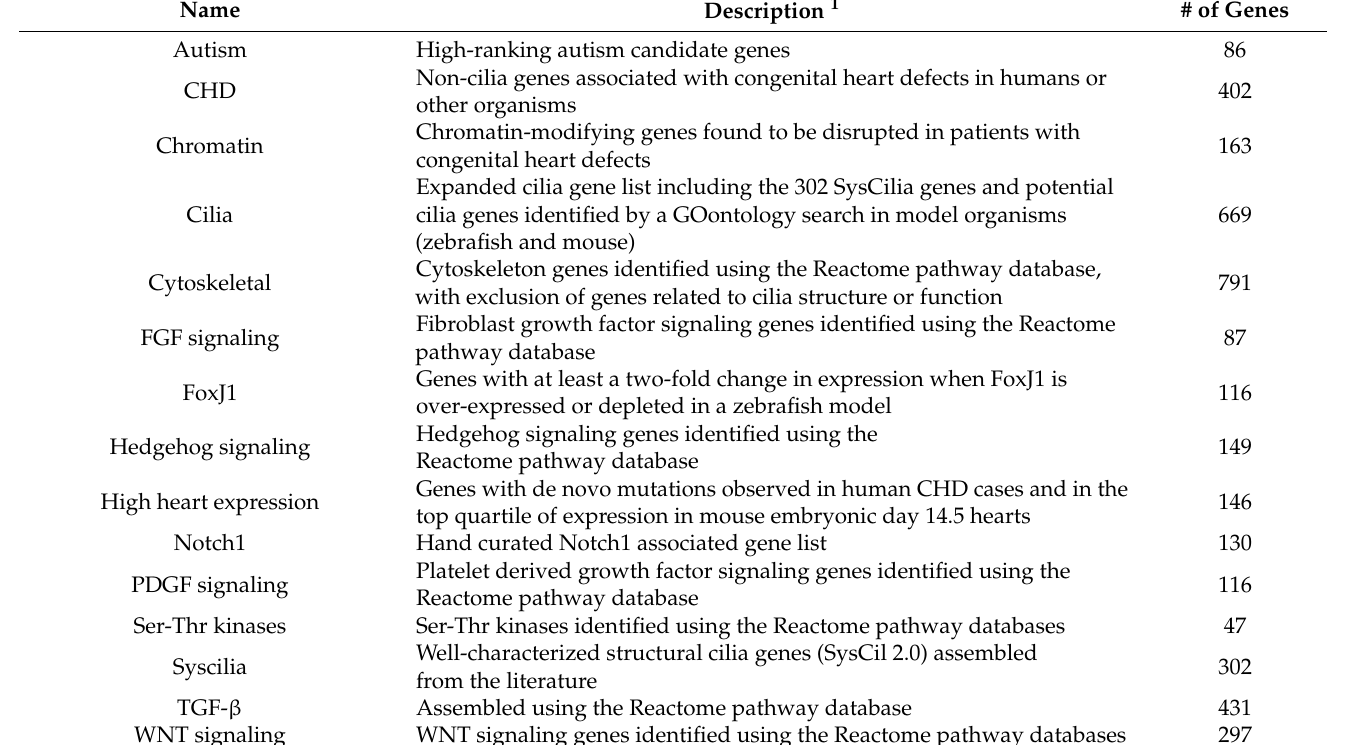
Table 1. CHD-related gene-sets analyzed for association with CTDs and